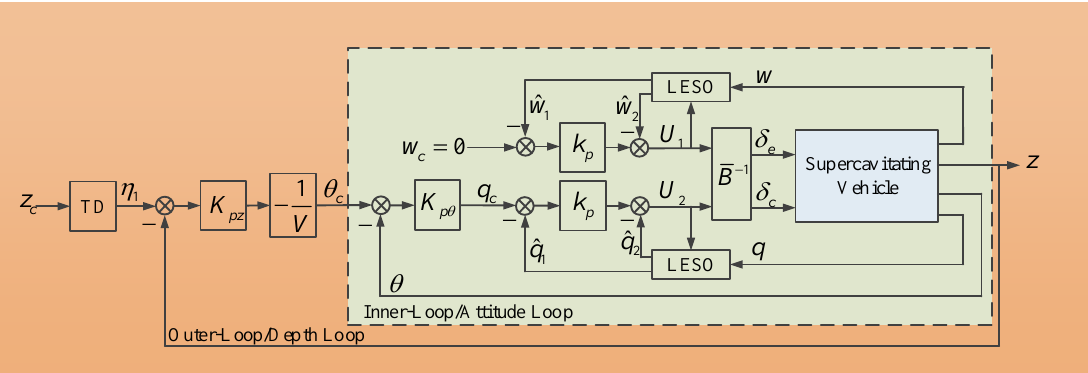
Figure 4. Block diagram of the depth and attitude coordinated control